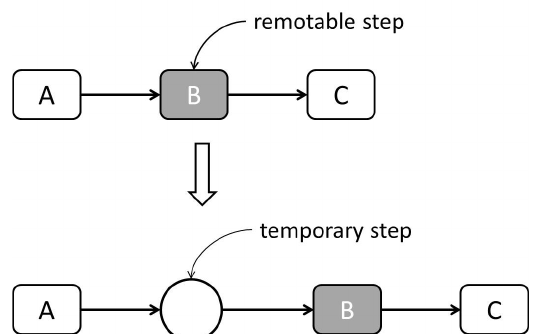
Figure 6: A temporary step is inserted before the remotable